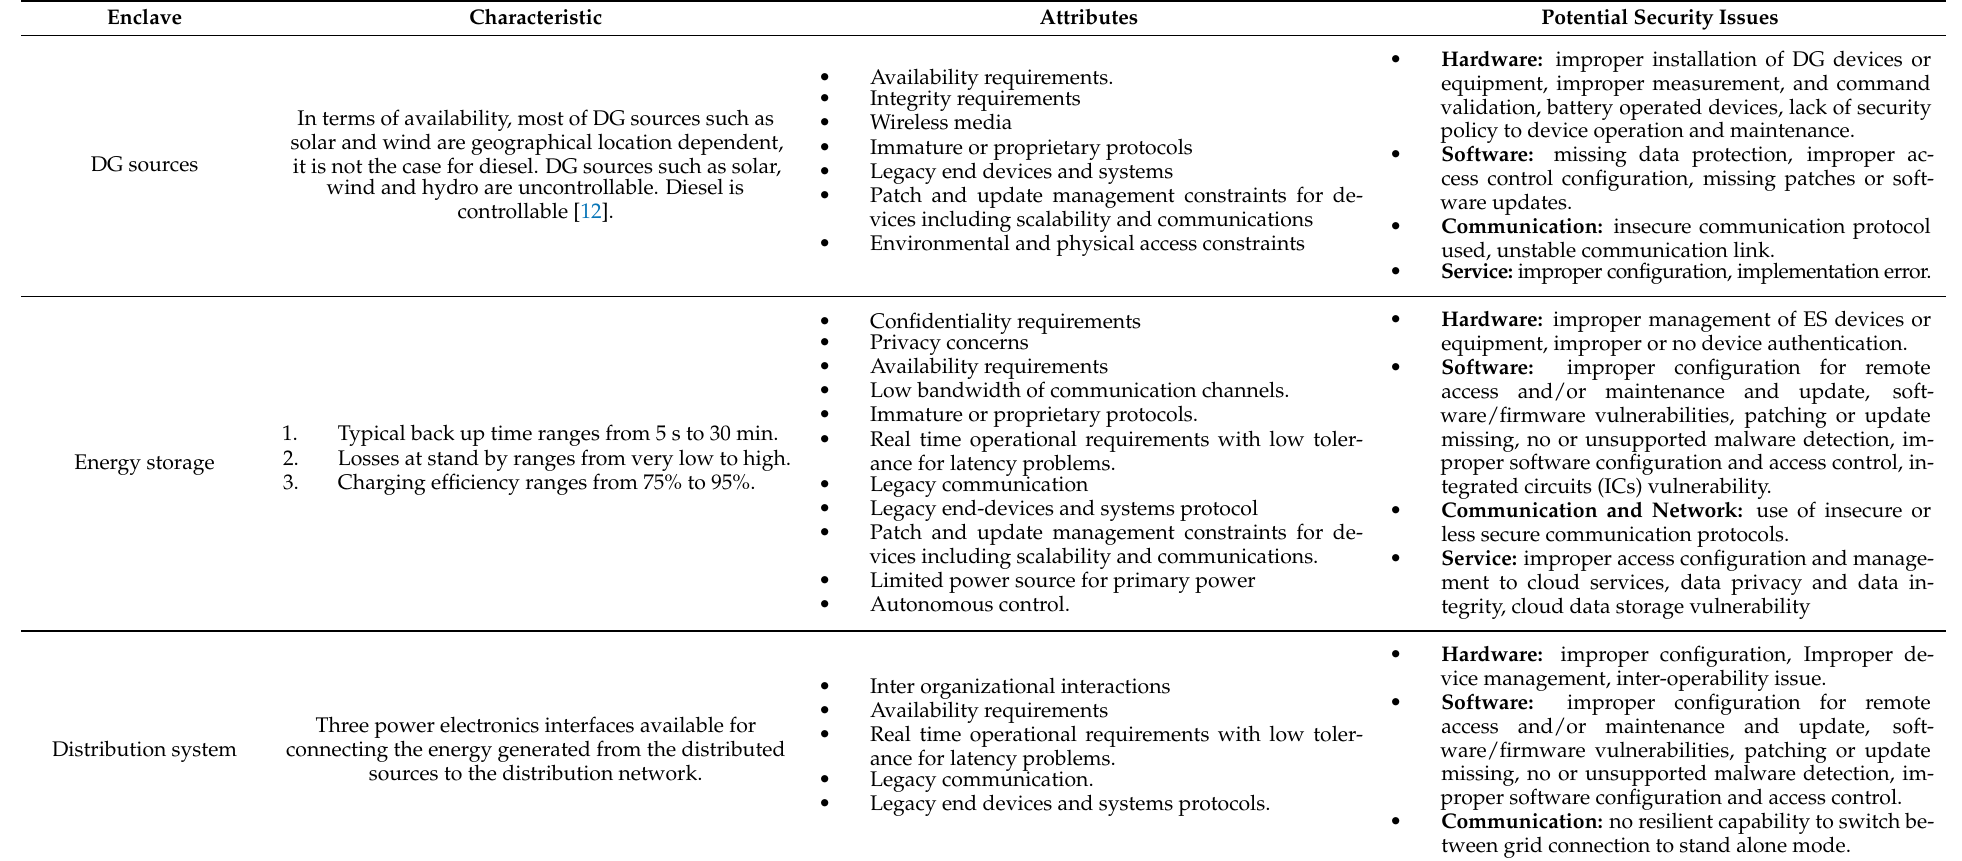
Table 3. Potential security issues for